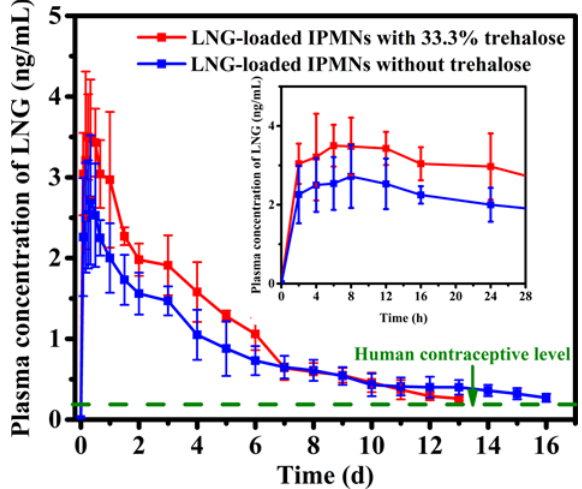
Figure 8. Plasma concentration of LNG versus time curves after administration of LNG-loaded IPMNs with 33.3% trehalose ( ■ ) and without trehalose ( ■ ) in vivo in rats (mean ± s.d., n = 6). The inset shows LNG concentration-time curves on the first day. The contraceptive LNG level in humans is shown by the green dashed line. The dose of LNG was 500 μg/rat.